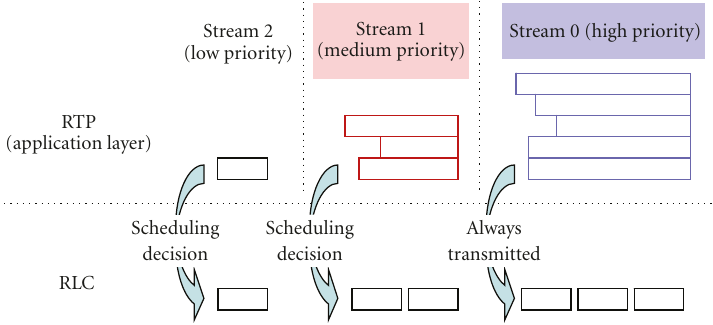
Figure 5: Scalable scheduling principle with three